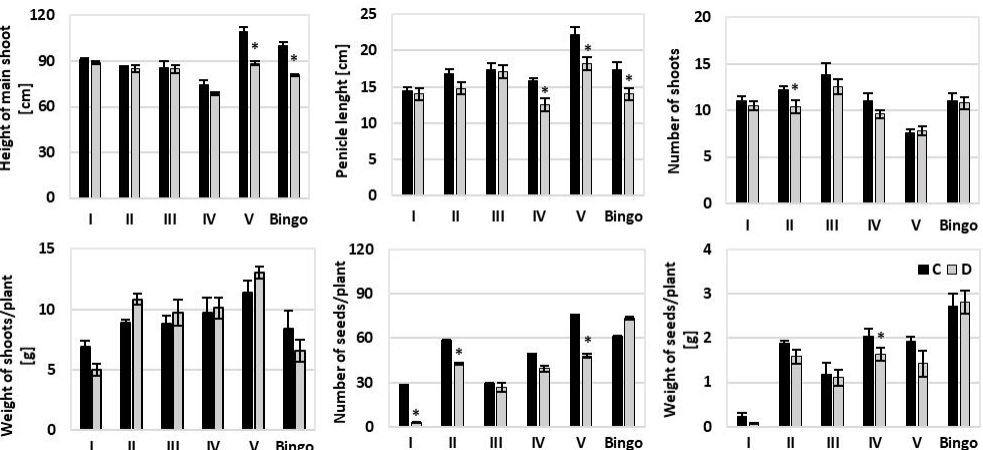
Figure 11. The impact of drought stress on the yield components of oat plants: height of the main shoot [cm], panicle length [cm], number of shoots, weight of shoots per plant [g], number of seeds per plant, weight of seeds per plant [g]. C—control, 70% FWC, black bars; D—drought, 25% FWC, grey bars. The mean values (n = 5) ± SE marked with an asterisk (*) are significantly different at p ≤ 0.05 according to the Student’s t test.